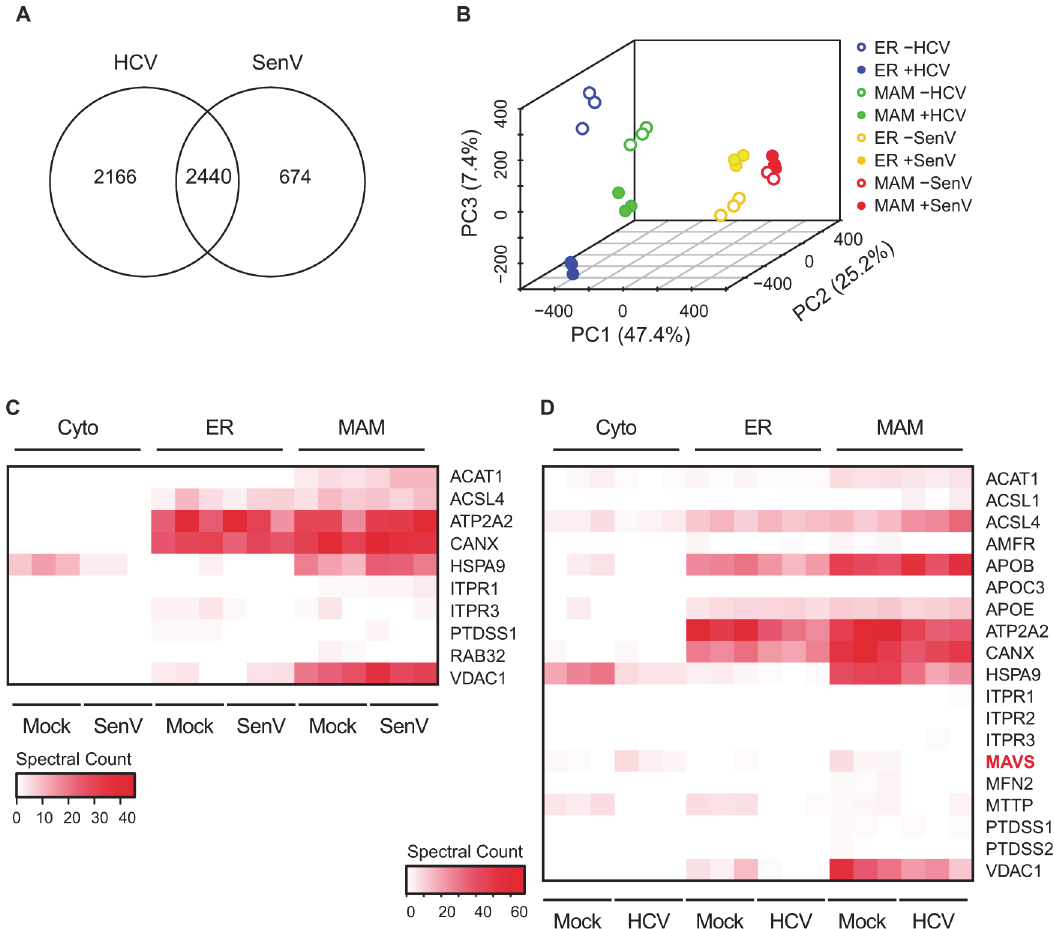
Fig 2. Proteomic analysis of subcellular fractions during RNA virus replication. (A) Venn diagram of total numbers of proteins identified in mock or virus samples in all biochemical fractions from Huh7 cells (mock or replicating HCV RNA) and from PH5CH8 cells (mock or after 8h of SenV infection). (B) Principal component analysis of mock and virus samples for both HCV and SenV from ER and MAM fractions. Each colored dot (open circle: no virus; closed circle; with virus) represents a technical replicate sample for each condition. The graph shows the first three independent principal components (PC1, PC2, and PC3), along with the percentage of variance captured within each component in parentheses. (C, D) Heat map of expression of proteins identified within subcellular fractions (Cytoplasm (Cyto), ER, and MAM) in SenV (C) or HCV (D) and mock samples, cross-referenced to a list of proteins known to have MAM localization (see S2 Table). The intensity of the red color indicates the normalized spectral counts of each protein across technical triplicates, as shown in the key. In (D) MAVS is highlighted in red to indicate the importance of its localization profile in HCV biology.